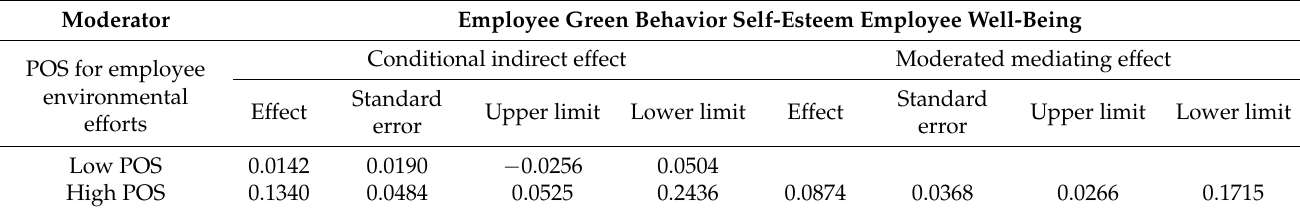
Figure 2. Moderating effect of perceived organizational support (POS) for employee environmental efforts. Table 6. The mediating effect and its 95% confidence interval at different levels of